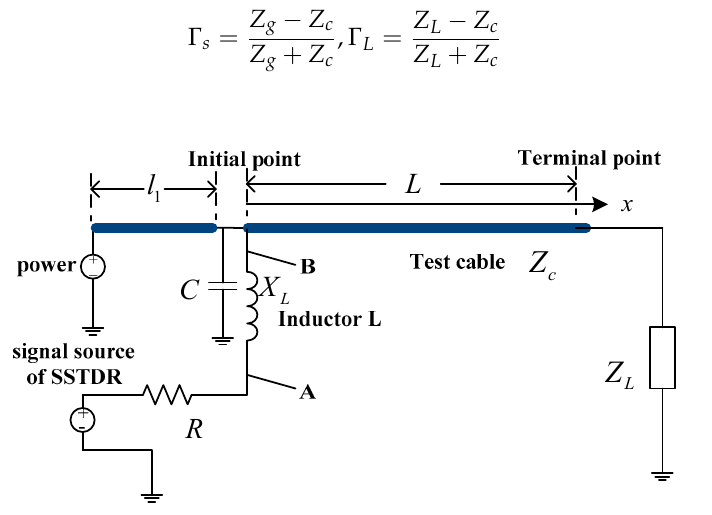
Figure 7. Equivalent circuit of inductive non-intrusive cable fault diagnosis.